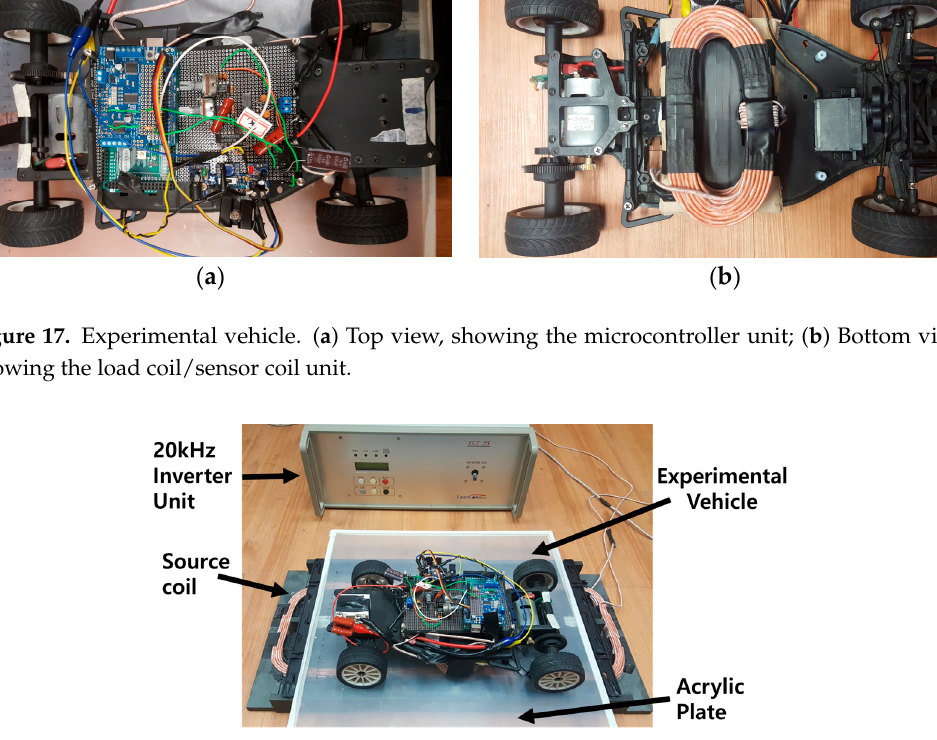
Figure 18. Experimental setup of the experimental vehicle with the ACAS unit.